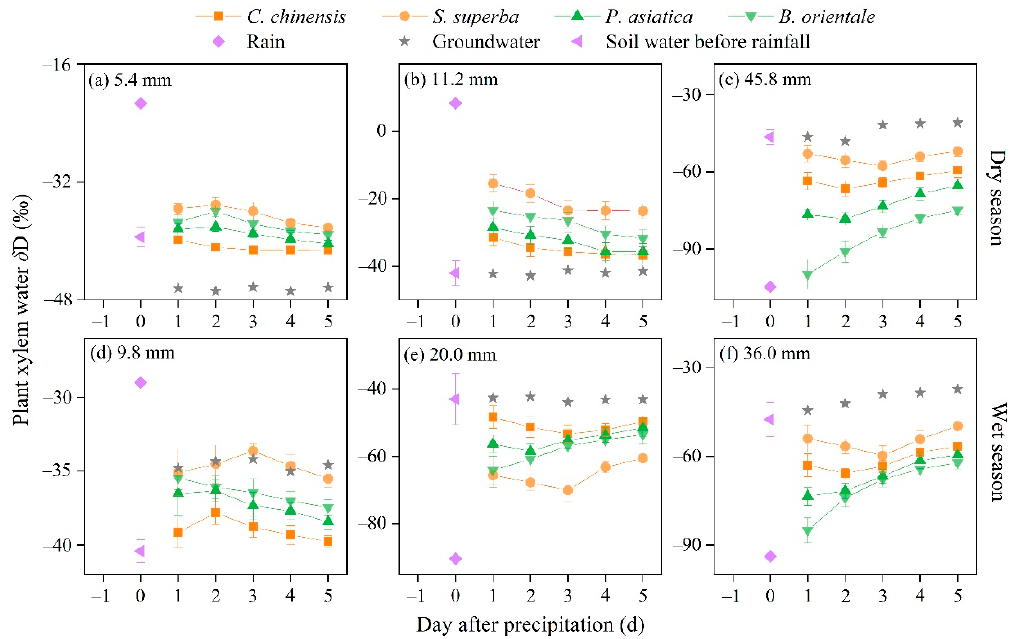
Figure 2. δ D values (mean ± SD) of soil water before rainfall, rainfall, groundwater, and plant stem water in the dry ( a , b , c ) and wet ( d , e , f ) seasons in the monsoon evergreen broad-leaved forest.